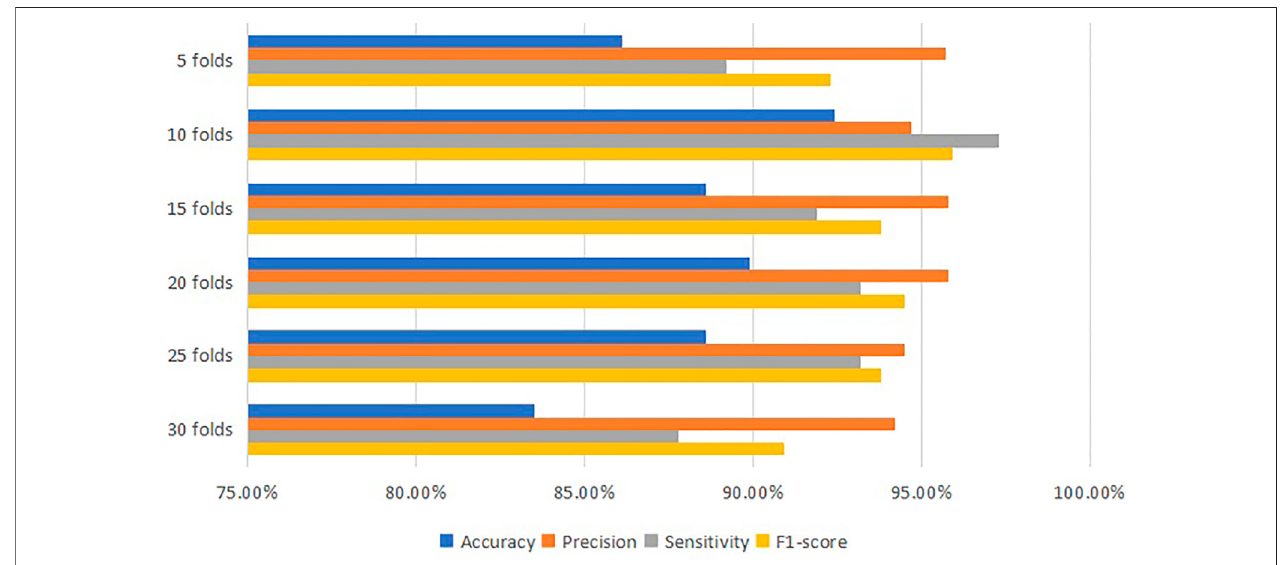
FIGURE 6 | Comparison diagram for the performance of NN classi fi er.